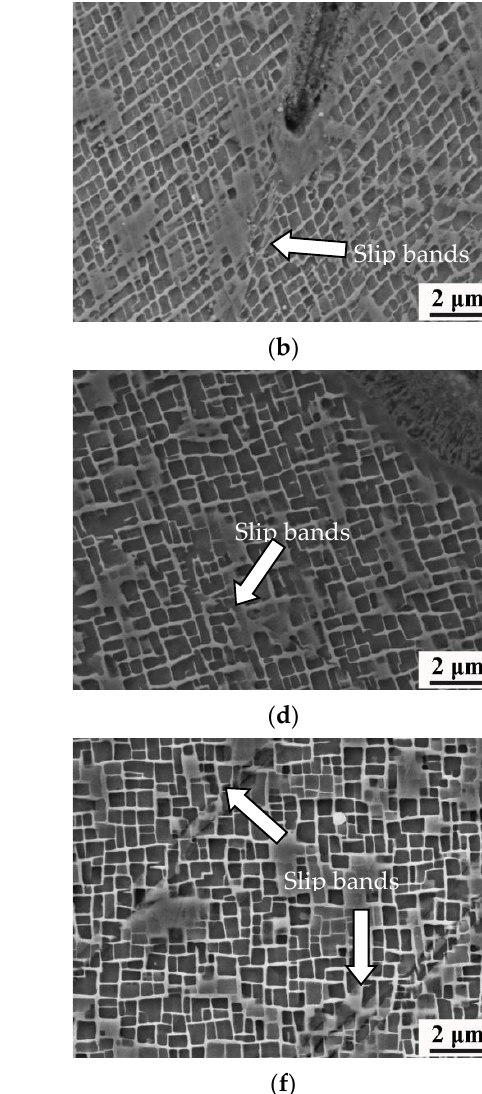
Figure 6. Tensile-fracture surfaces and longitudinal morphologies of DD9 alloy with LABs at 1100°C: ( a , b ), 3.7°; ( c , d ),4.8°;( e , f ), 6.0°; ( g , h ), 8.9°; ( i , j ), 11.4°.